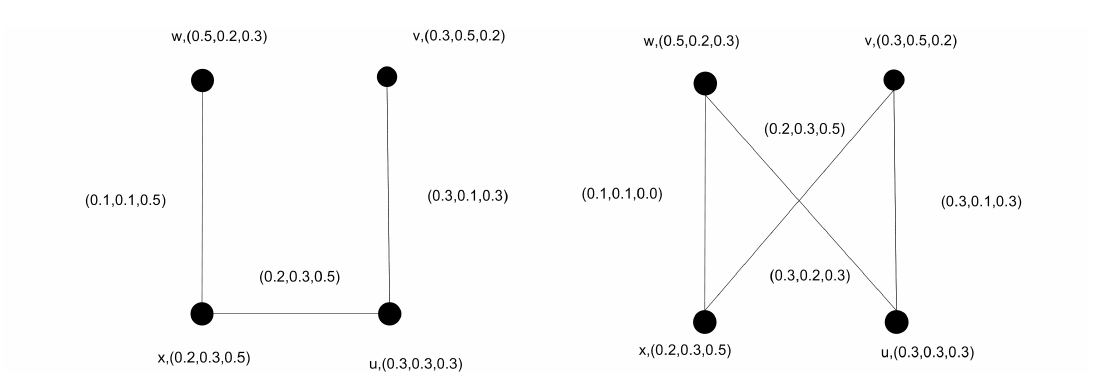
Figure 4. A picture fuzzy graph and its complement picture fuzzy